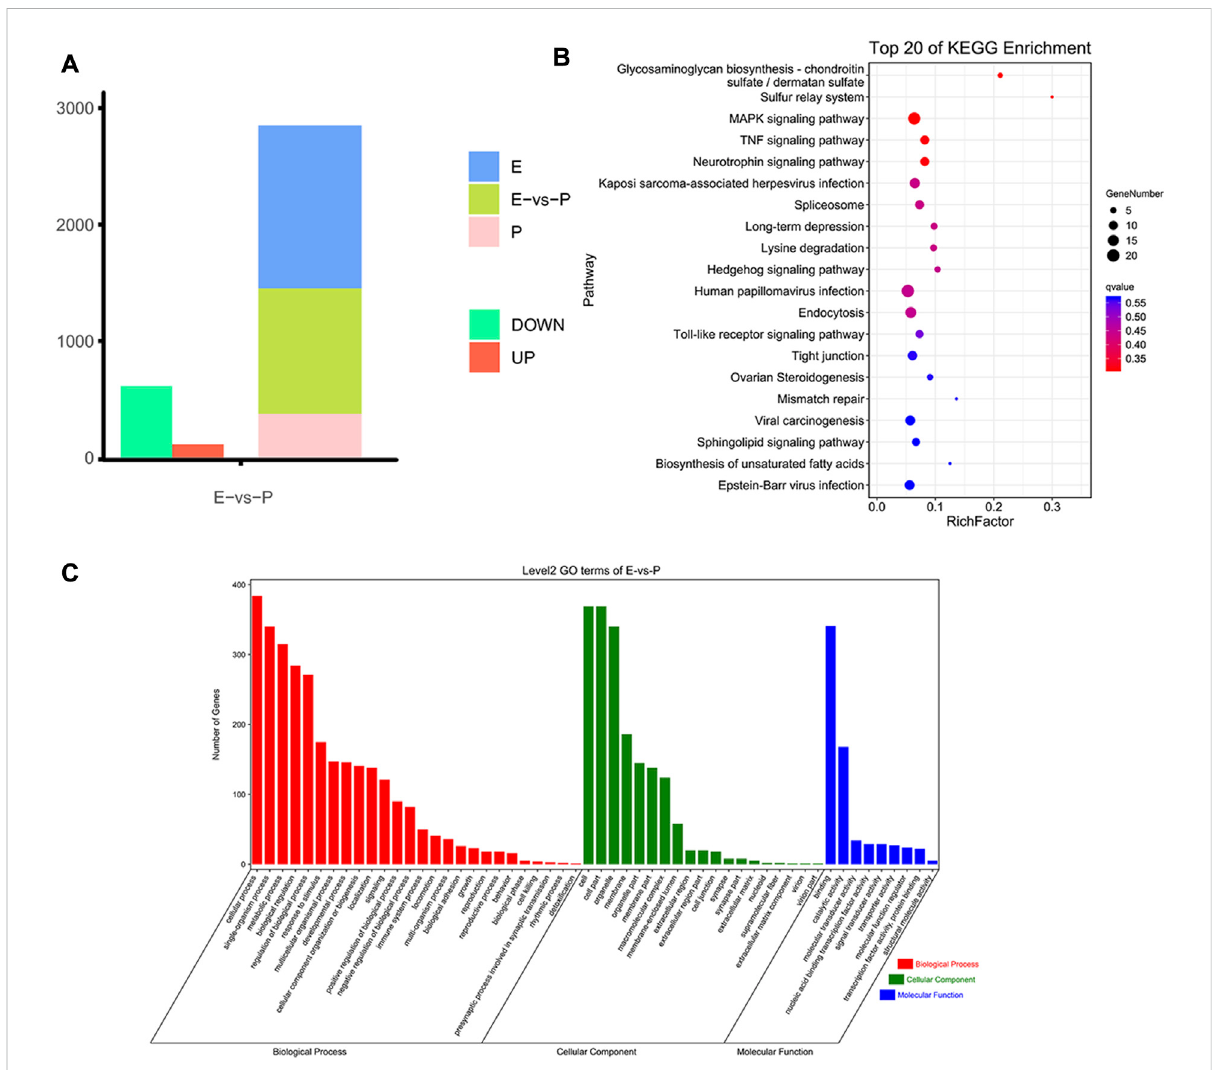
FIGURE 4 Identi fi cation and functional analysis of m 6 A peaks. (A) Peak identi fi cation during different lactation stages. (B) Enrichment results for the top 20 DMGs pathways. (C) GO annotation enrichment results for